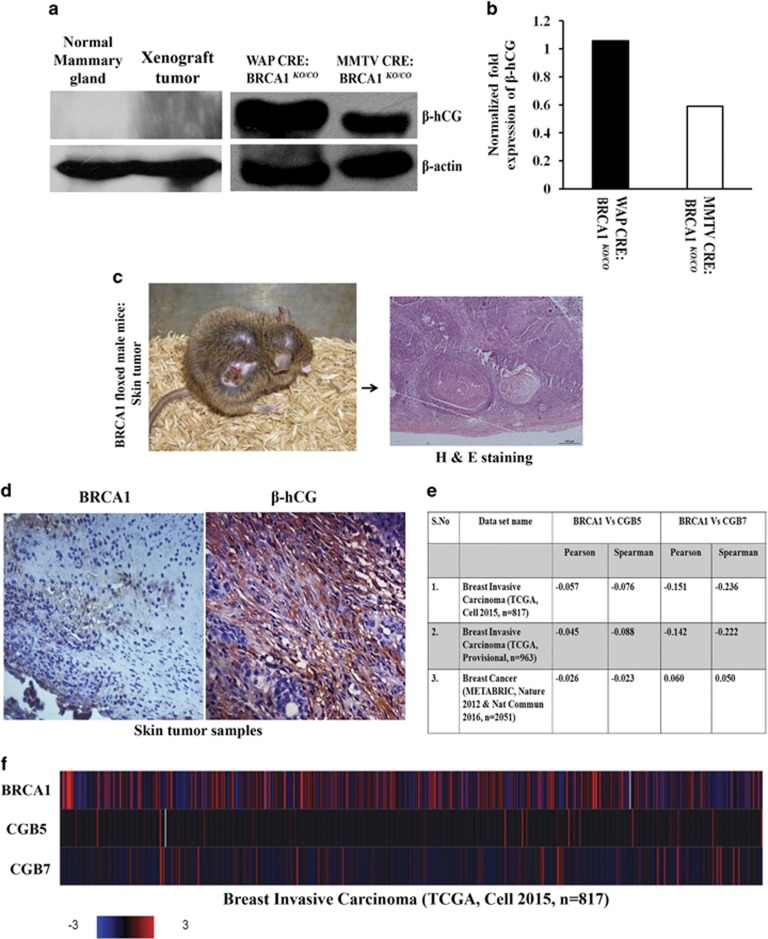
Loss of BRCA1 induces β-hCG expression in vivo. (a) Western blot analysis of β-hCG expression in normal mammary gland, xenograft tumor developed using MDAMB-231 cells and mouse mammary tumor of BRCA1 floxed conditional knockout mouse tissue generated from WAP-Cre; BRCA1KO/CO and MMTV-Cre; BRCA1KO/CO animals. (b) Adjacent panel represents the quantitation of western blot of WAP-Cre; BRCA1KO/CO and MMTV-Cre; BRCA1KO/CO. (c) BRCA1 floxed male mouse showing the skin tumor. Right panel shows H & E staining of tumor region. (d) IHC analysis of β-hCG and BRCA1 in skin tumor of BRCA1 floxed mouse tumor tissues. (e) Table showing the pearson and spearman correlation values between BRCA1 vs CGB5 and BRCA1 vs CGB7 from three different human breast cancer dataset. (f) Heat map showing the expression levels of BRCA1, CGB5 and CGB7 from breast invasive carcinoma dataset (TCGA, cell 2015).